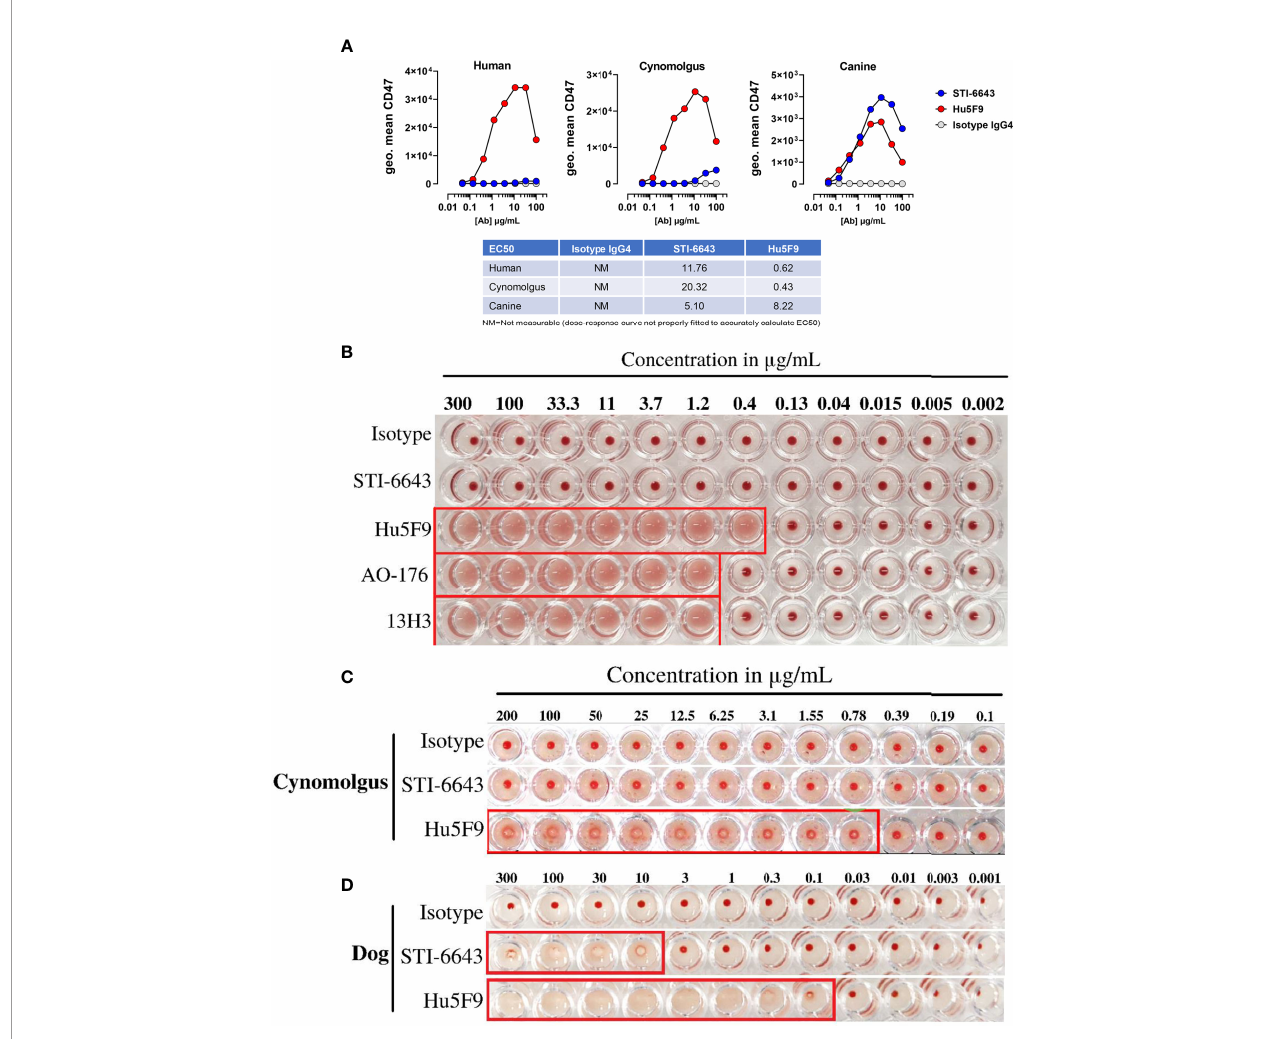
FIGURE 2 | STI-6643 showed negligible RBC binding and hemagglutination compared to reference anti-CD47 clones (A) Binding of STI-6643 (blue), Hu5F9 (red) and isotype control (grey) antibodies to human (left), cynomolgus monkey (middle) and canine (right) RBCs. (B) Hemagglutination activity of anti-CD47 mAbs clones STI-6643, Hu5F9, 13H3 and AO-176 or isotype control on human RBCs at 20 hours post incubation at 37°C. Hemagglutination of cynomolgus monkey (C) and dog (D) RBCs induced by STI-6643 and Hu5F9. A matching isotype IgG 4 antibody was used as negative control. Data are representative of one (A) , two (B) , three (C, D) , independent